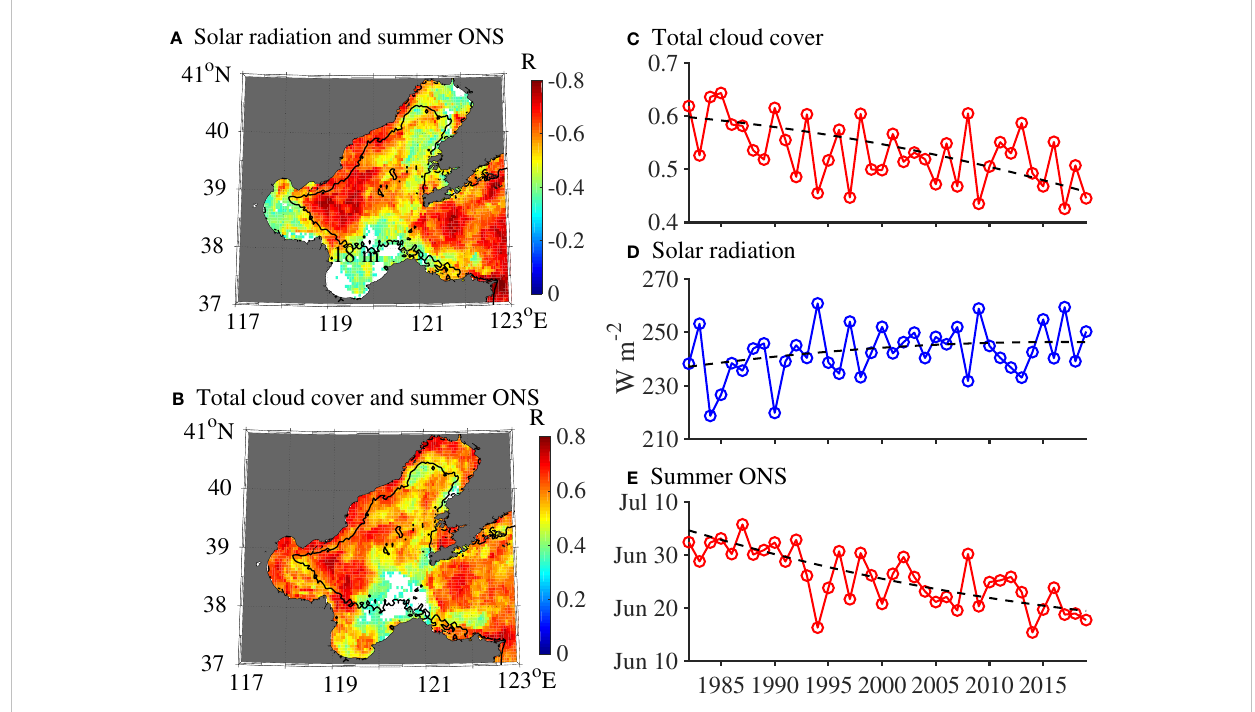
FIGURE 7 Correlation coef fi cients in the Bohai Sea between time series of (A) the late spring solar radiation and the summer ONS, (B) the late spring total cloud cover (TCC) and the summer ONS. Only signi fi cant correlations at the con fi dence level of 95% are shown in the fi gures. Black contour is the same as Figure 4. Spatially averaged time series of (C) the late spring TCC, (D) the late spring solar radiation and (E) the summer ONS during the 1982 – 2019. Black dash line denotes the secular trend derived from the EEMD